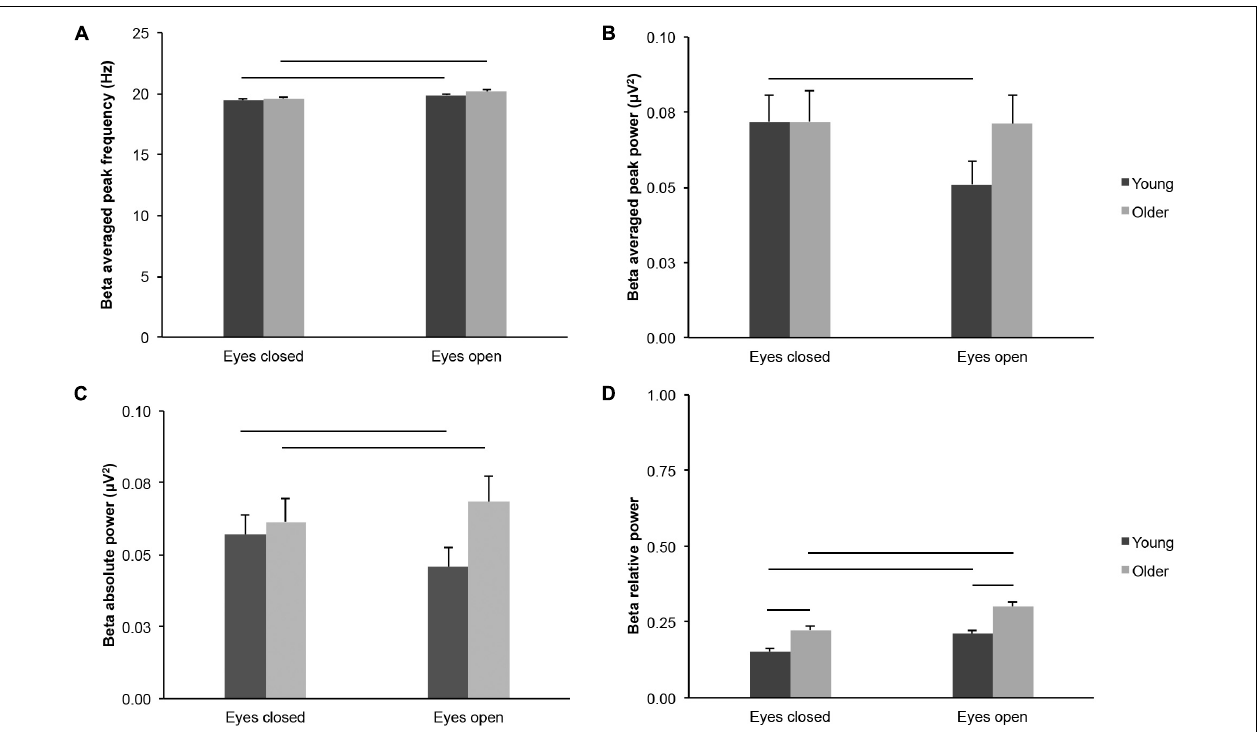
FIGURE 4 | Beta-band activity measured across the scalp in healthy 20–30-year-old (Young; dark gray bars) and 65–75-year-old (Older; light gray bars) adults. (A) Beta averaged peak frequency. (B) Beta averaged peak power. (C) Beta absolute power. (D) Beta relative power. Average ± SEM. Horizontal bars indicate statistically significant differences between age groups or eye conditions ( p <